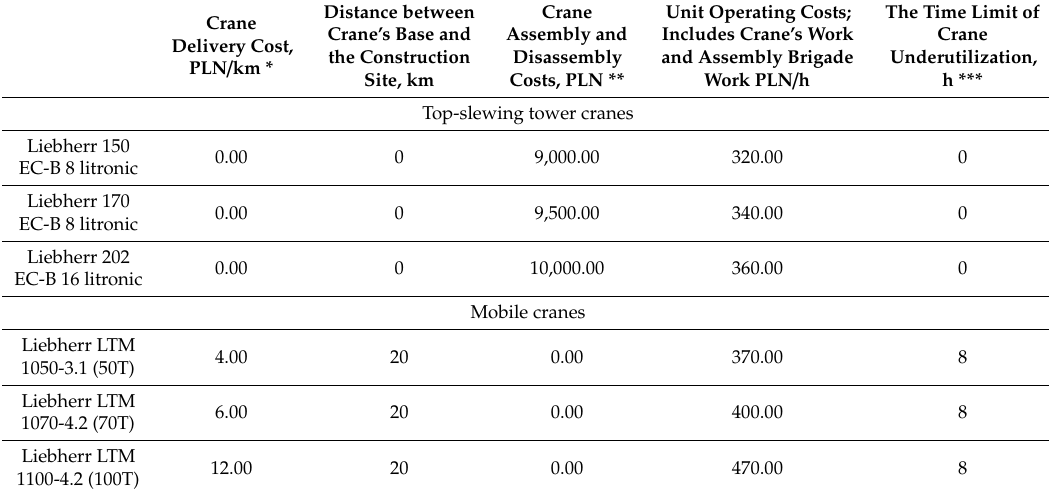
Table 2. Cost characteristics of the assembly machines shown in the example. Sourced from our own study.